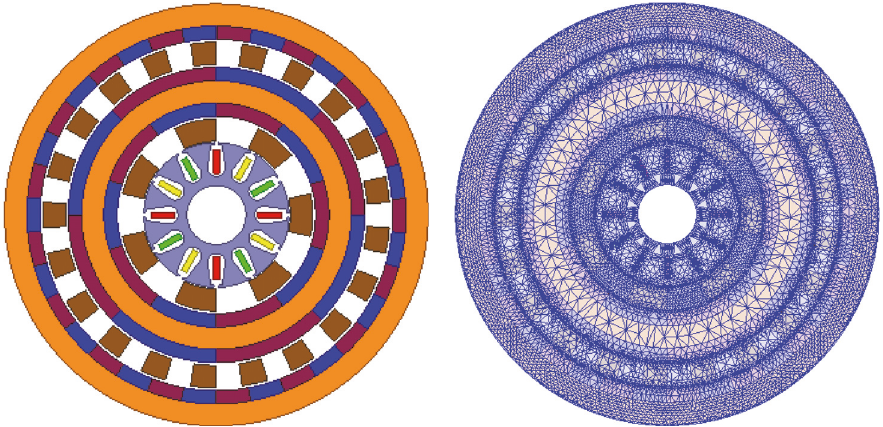
Figure 3: FEM of the example EIMG system.